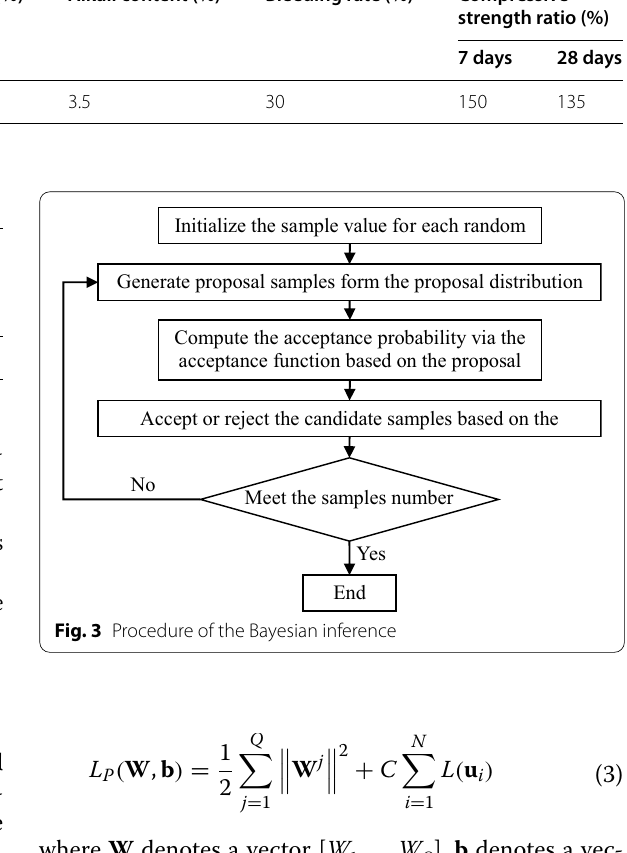
Table 2 Basic properties of the water reducing agent Water reduction (%)